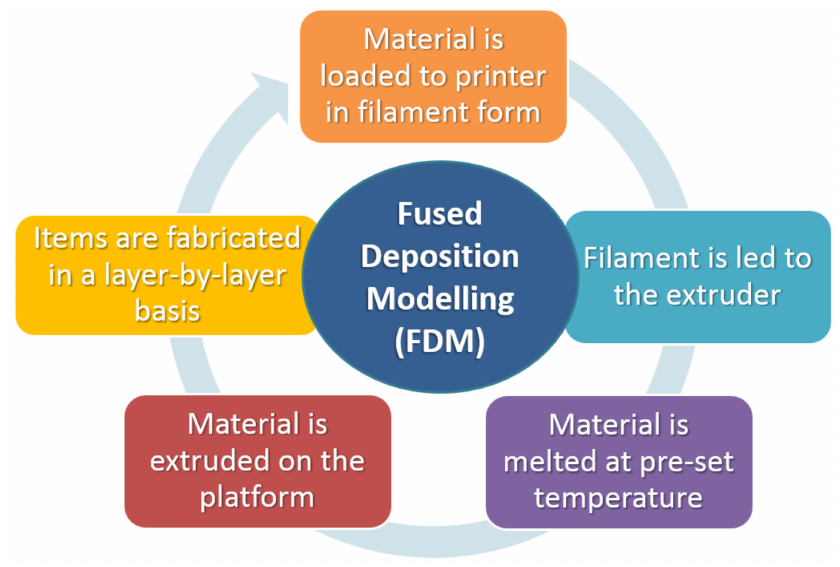
Figure 2. Distinct stages of the fused deposition modelling (FDM)